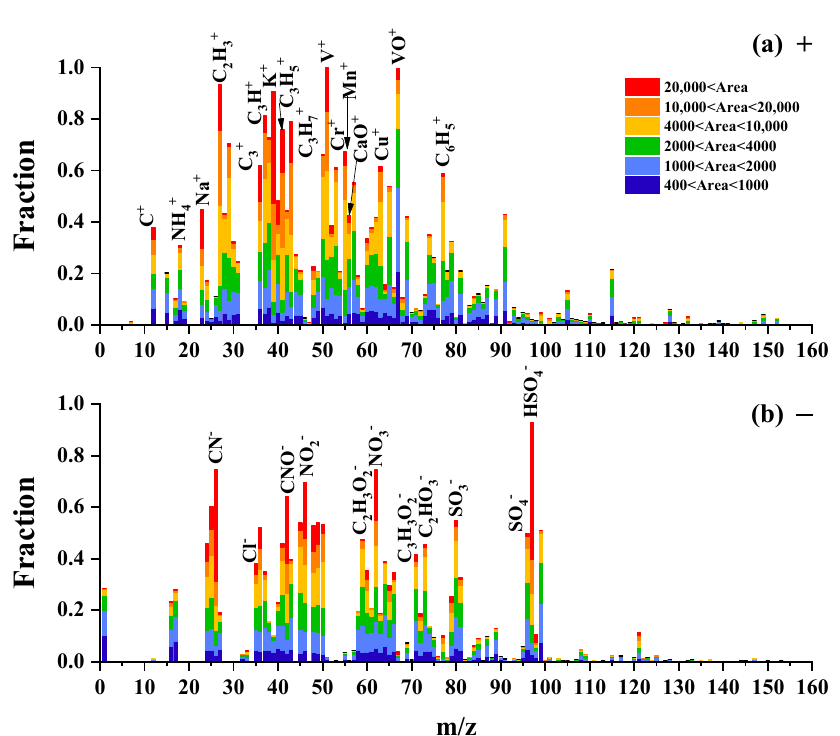
Figure 4. Mass spectra of V single particles. The color bars represent the peak areas corresponding to a speci fi c ion in the single particles.